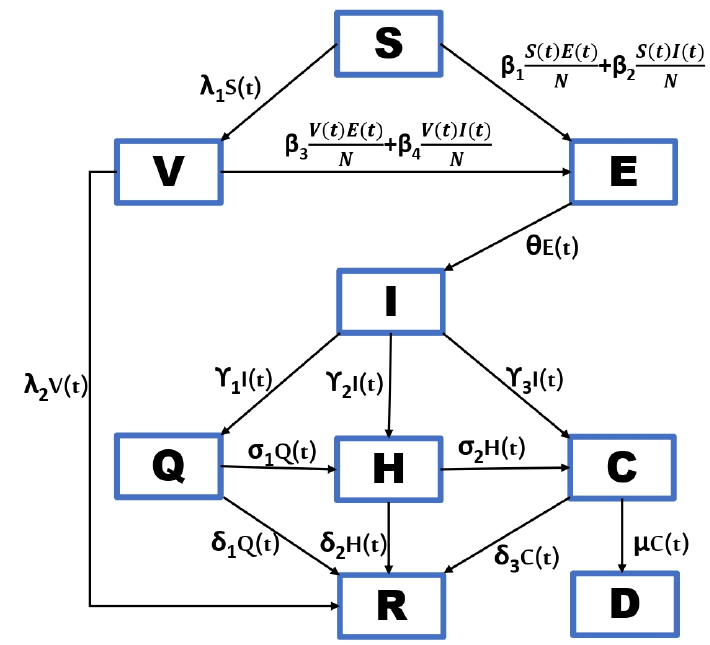
Figure 1. Flow chart of the